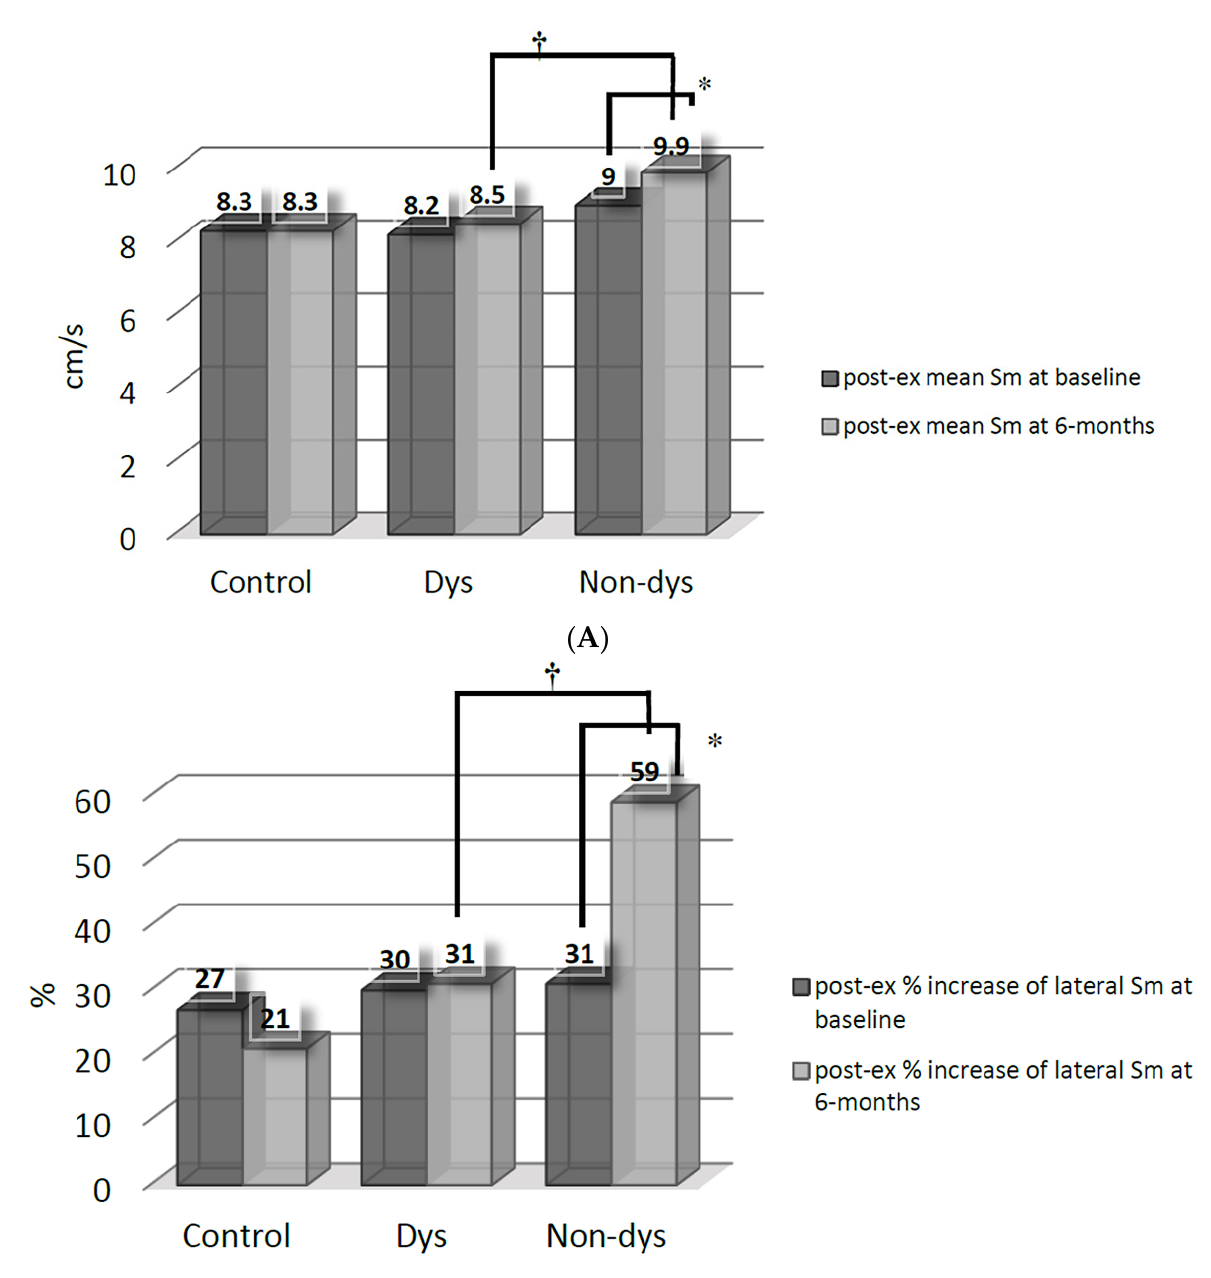
Figure 1. ( A ) Comparisons of post-exercise (post-ex) mean systolic myocardial velocity (Sm) between the dyssynchrony (Dys) and non-dyssynchrony (Non-dys) groups at baseline and at 6 months after spironolactone therapy. * p < 0.05 versus baseline; † p < 0.05 between the Dys and Non-dys subgroups. ( B ) Comparisons of post-exercise (post-ex) % increase of systolic myocardial velocity (Sm) between dyssynchrony (Dys) and non-dyssynchrony (Non-dys) group at basal-lateral segment at baseline and at 6 months after spironolactone therapy. * p < 0.05 versus baseline; † p < 0.05 between Dys and Non-dys subgroup .